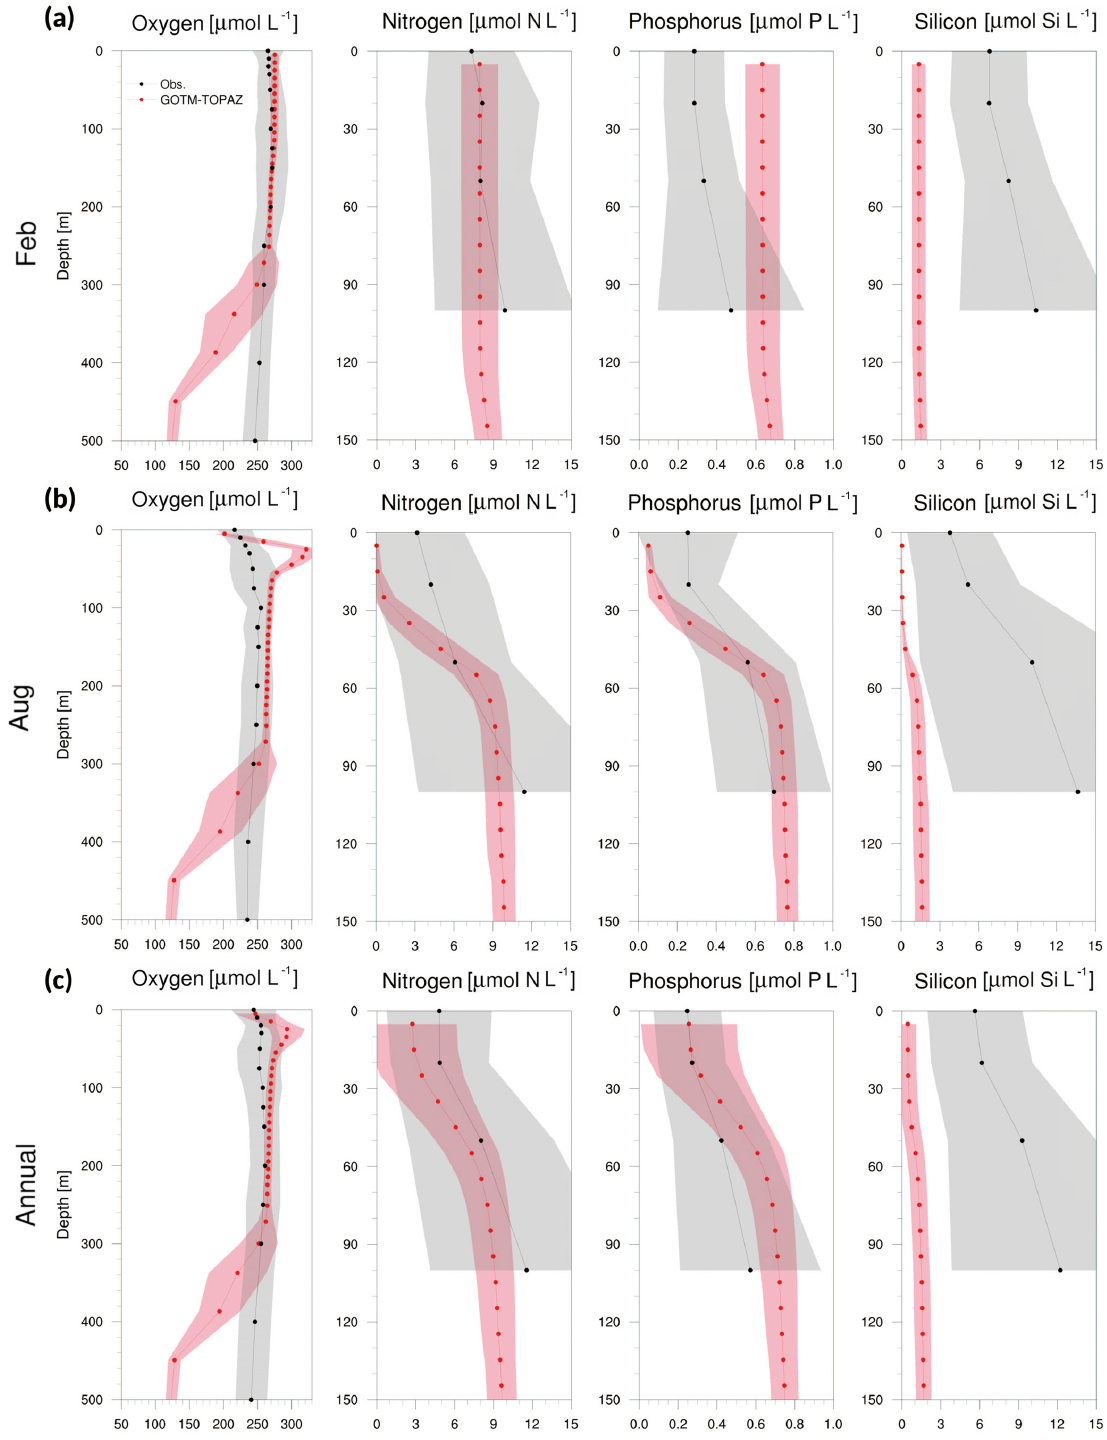
Figure 8. Vertical profiles from observational data (black dots) and GOTM–TOPAZ results (red dots) at point 107 for concentrations of dissolved oxygen, nitrogen, phosphorus, and silicon averaged from 1999 to 2008, (a) for February, (b) for August, and (c) annually. The shaded areas represent 1 σ . In this figure, nitrogen, phosphorus, and silicon include NO 3 , PO 4 , and SIO 4 ,